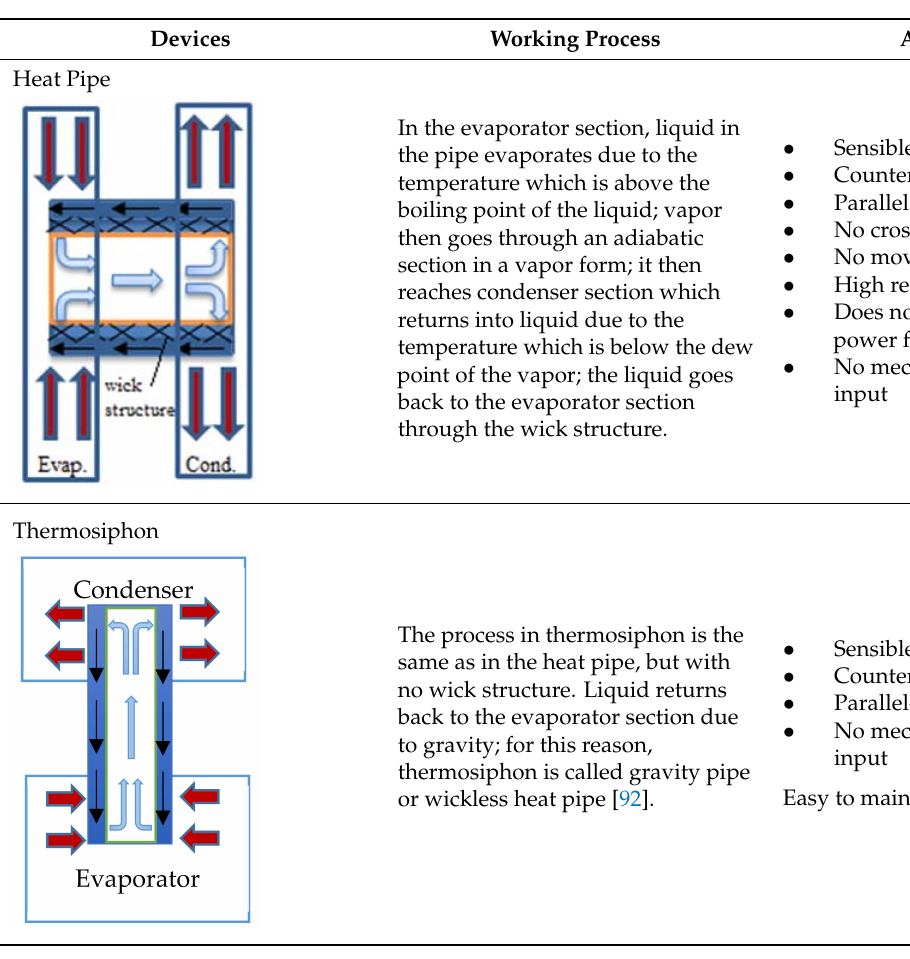
Table 1. Summary of energy and heat recovery